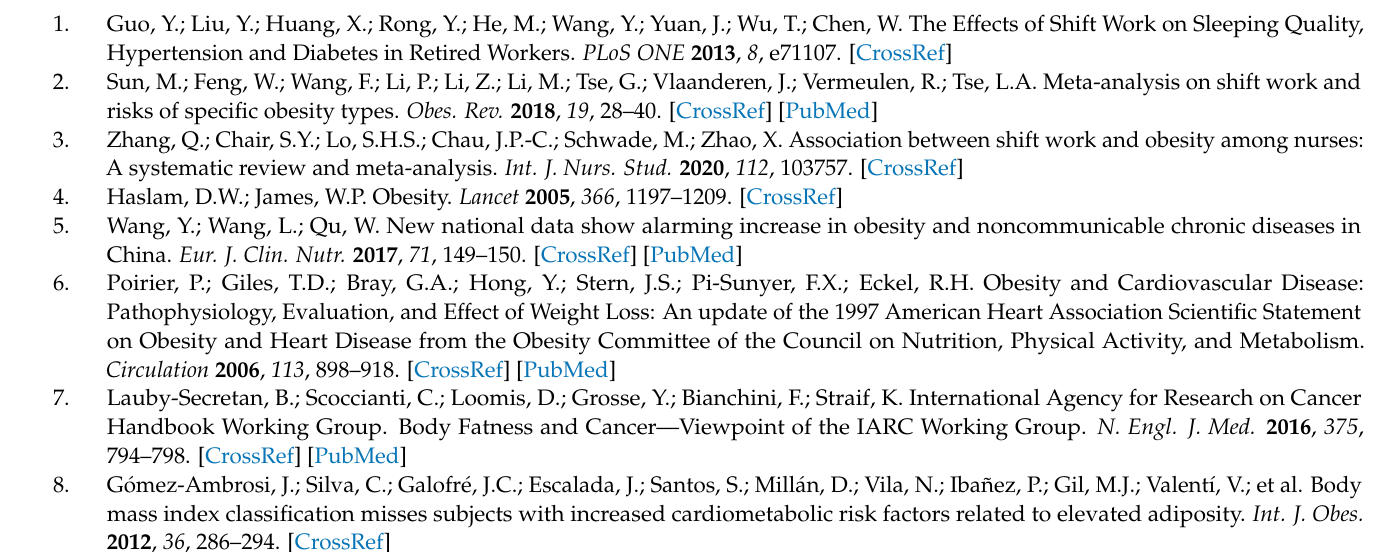
Table S5: Association between different exposure metrics of night shift work and obesity odds (defined by BF% ≥ 35%) among nonobese-BMI participants (BMI < 28 kg/m 2 ), Table S6: Associations of duration of night shifts with BF% and FMI from generalized linear models, Figure S1: Associations of duration of night shifts (continuous), cumulative number of night shifts (continuous), and cumulative length of night shifts (continuous) with BMI, FMI, and BF% from restricted cubic spline models after further adjusting for the major occupational hazards, Figure S2: Associations of duration of night shifts (continuous), cumulative number of night shifts (continuous), and cumulative length of night shifts (continuous) with BMI, FMI, and BF% from restricted cubic spline models after further adjusting for